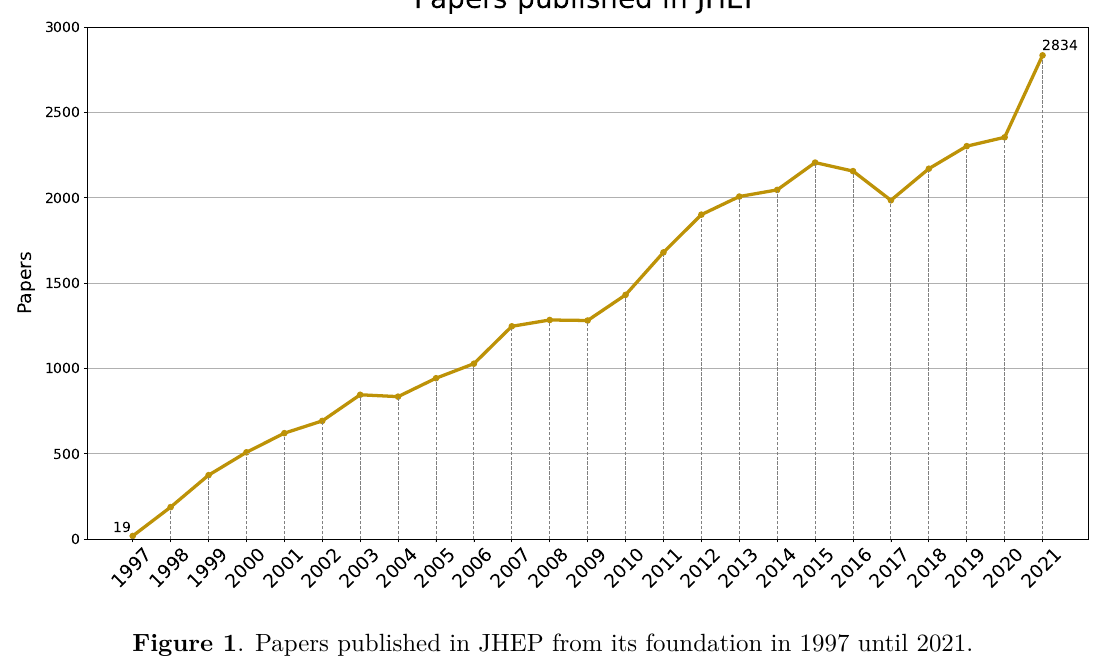
Figure 1 . Papers published in JHEP from its foundation in 1997 until